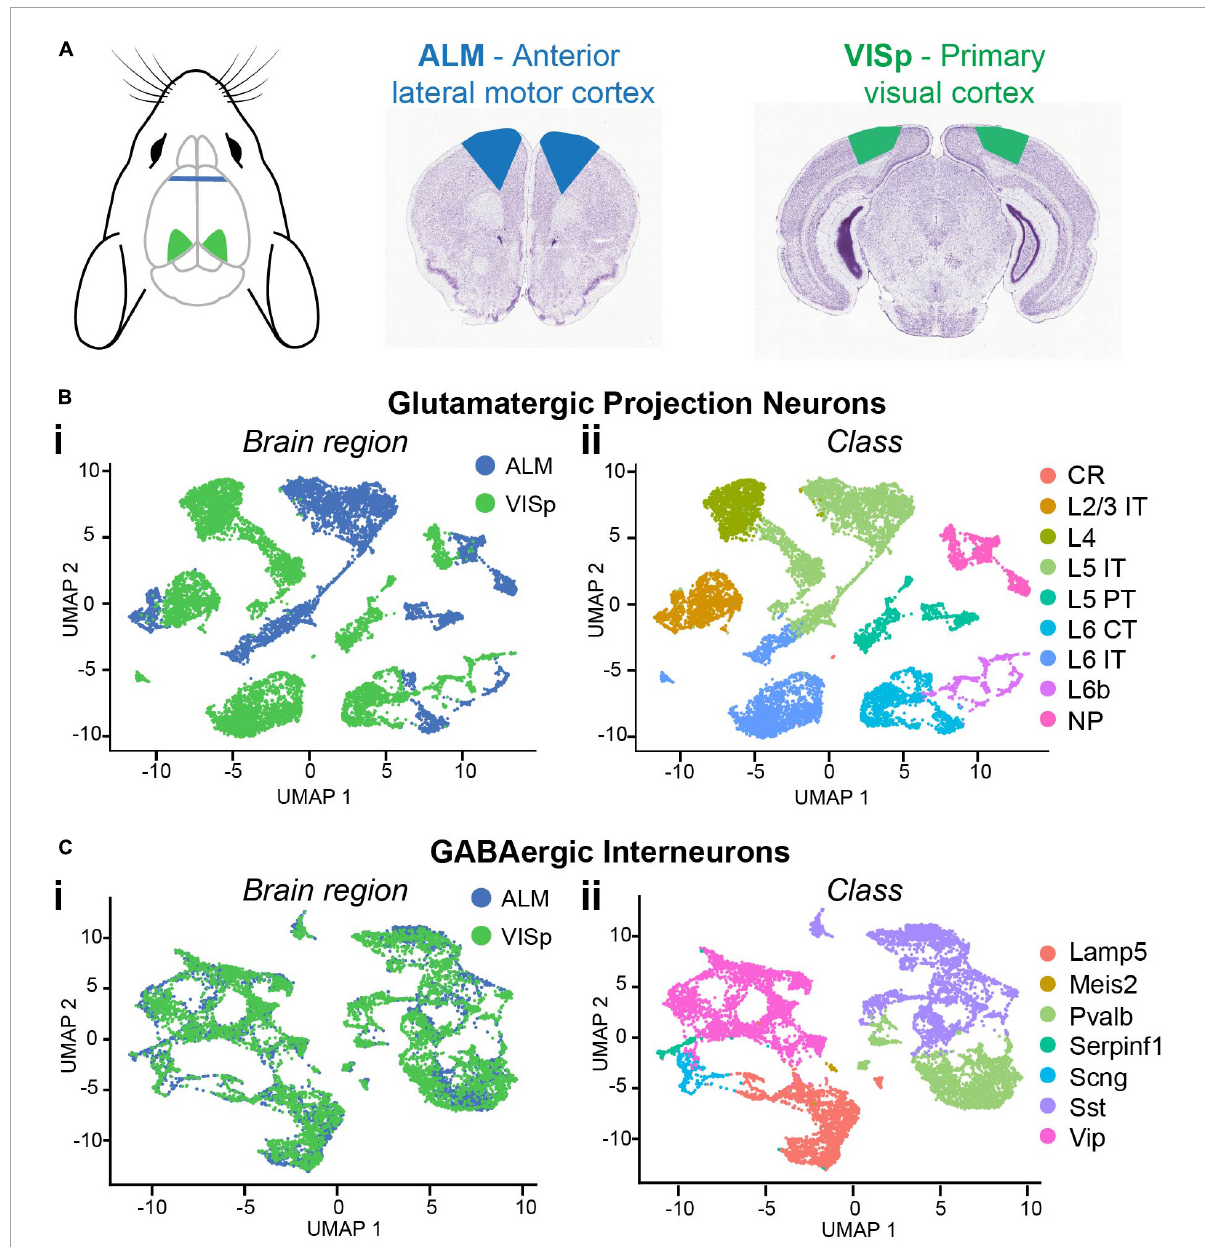
FIGURE1 Single-cell RNA-seq data for major neuronal classes in ALM and VISp. (A) Anatomical locations of ALM (blue) and VISp (green) with corresponding coronal sections. Mouse cartoon modified from SciDraw (doi: 10.5281/zenodo.3925903). (B) UMAP dimensionality reduction for glutamatergic cells color-coded using metadata for brain region (Bi) or class (Bii) . (C) UMAP dimensionality reduction for GABAergic cells color-coded using metadata for brain region (Ci) or class (Cii) . L2/3 IT, L5 IT, L5 PT, L6 CT, Pvalb, Sst, and Vip clusters were selected for downstream analysis. CR, Cajal–Retzius; IT, intratelencephalic; PT, pyramidal tract; CT, corticothalamic; NP, near-projecting; Pvalb, parvalbumin; Sst, somatostatin; Vip, vasoactive intestinal peptide. Coronal sections adapted from the Allen Mouse Brain Atlas (https://mouse.brain-map.org/static/atlas).